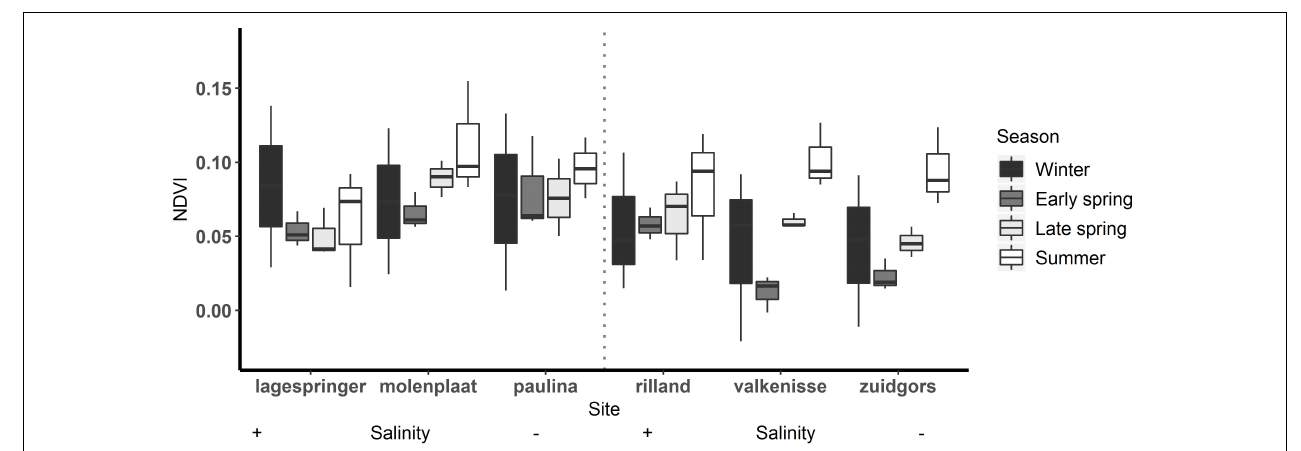
FIGURE 2 | MPB biomass, expressed as the NDVI, on each tidal flat per season. Winter: December to February, early spring: March to April, late spring: May to June, summer: July.